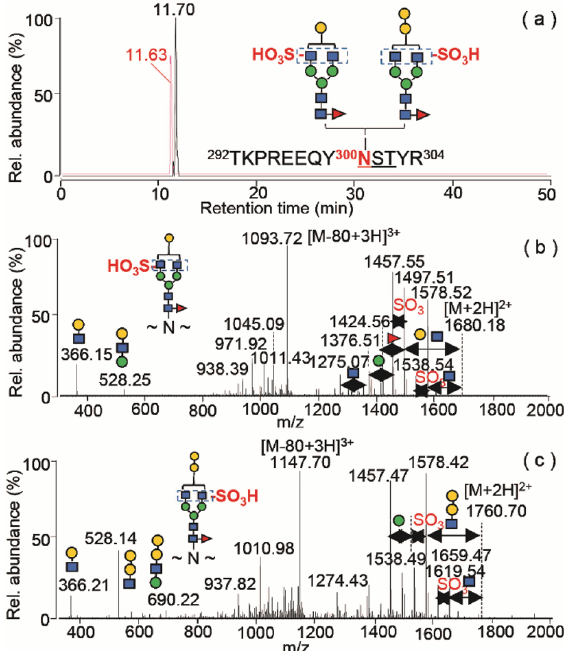
1120.1225; ( c ) MS/MS spectrum of the [G1F + α-Gal] containing glycopeptide of m/z